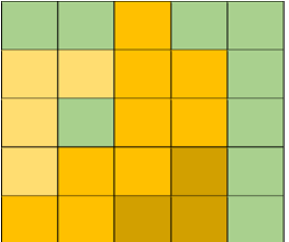
Figure 2. Example in which compensation is carried out in an urban area (the industrial area in Figure 1 turned into urban green space of type 1) with a heterogeneous population represented by the yellow-colored